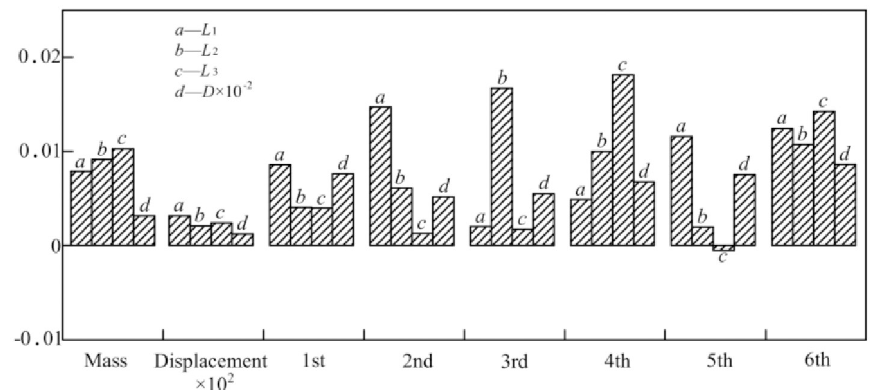
Fig 11. Sensitivity analysis chart of L 1 , L 2 , L 3 and D to each performance.